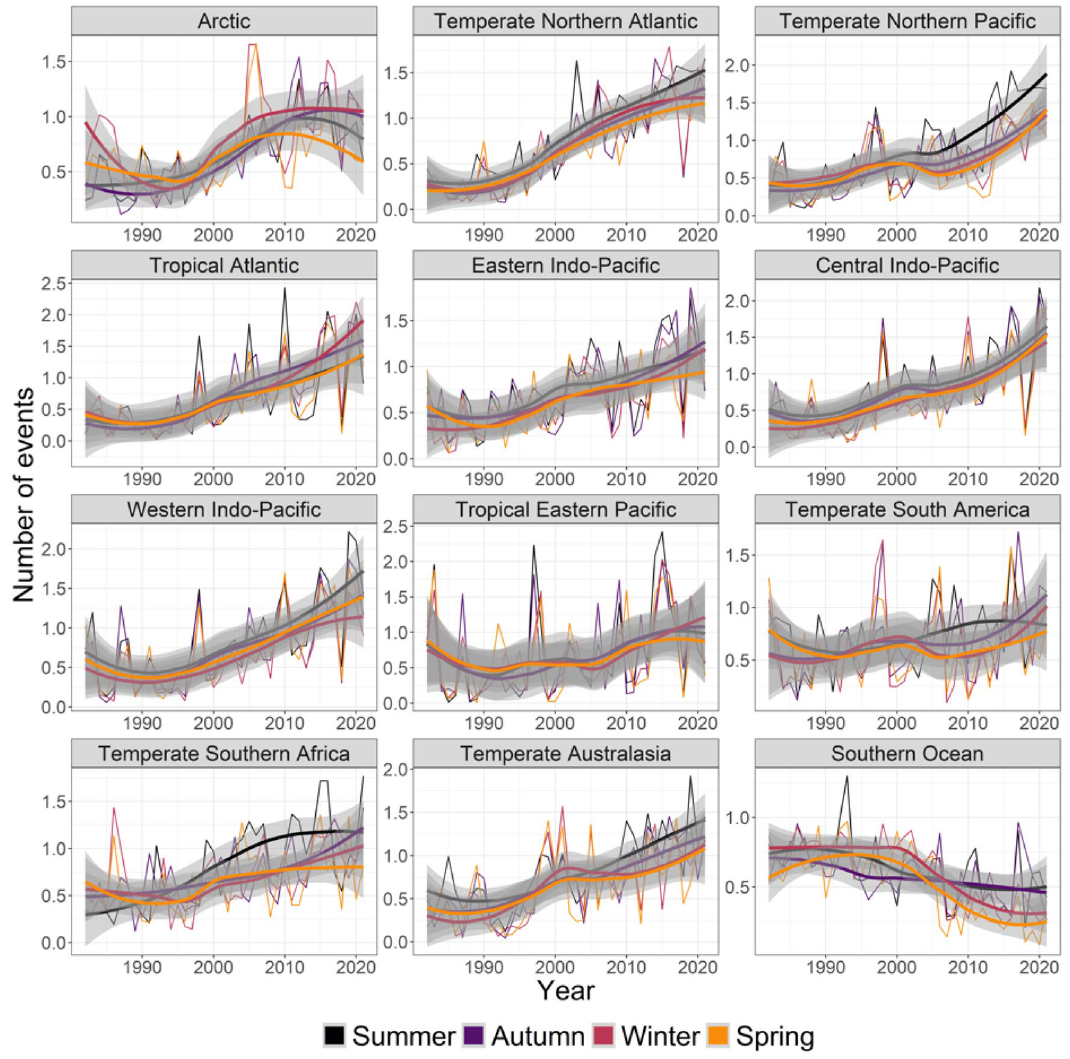
Figure 4. Seasonal trends from 1982 to 2021 in the yearly- and pixel-averaged number of marine heatwaves (events) per coastal realm and season. See Fig. 2 caption for more details and Table S4 for specific trendlines, p values and break point